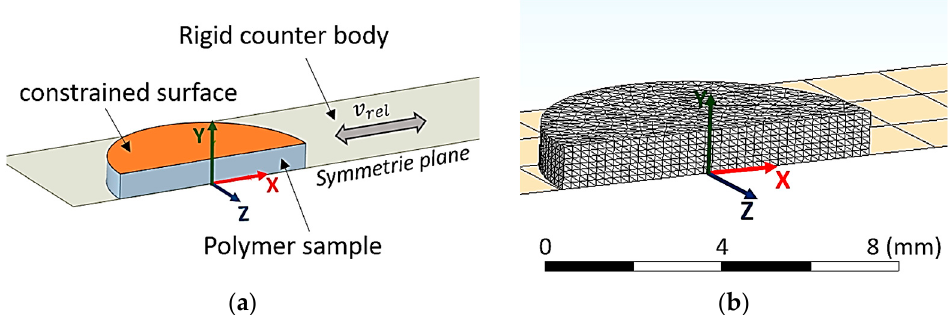
Figure 4. Simulation setup for parameter study with 14,115 linear tetrahedral elements: ( a ) bound- ary conditions; ( b ) mesh of the discretized model.